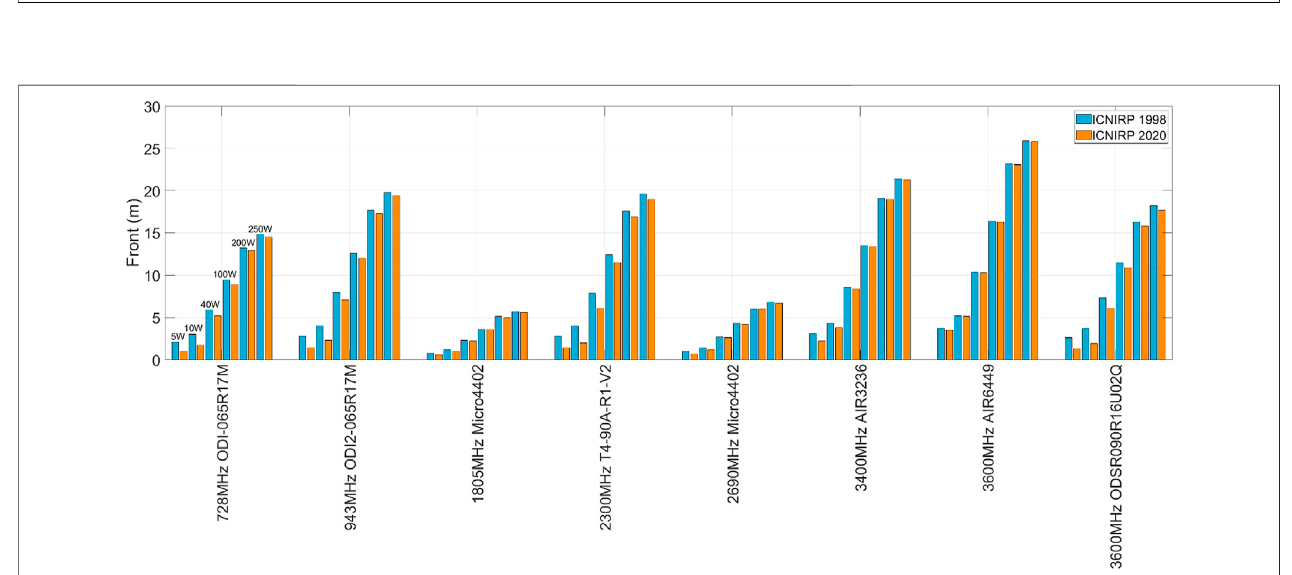
FIGURE 3 | Dimensions of the compliance boundary box in the front direction for the selected BS antennas (for frequencies below 6 GHz) obtained by applying ICNIRP 1998 and ICNIRP 2020 general public reference levels for input powers of 5, 10, 40, 100, 200, and 250 W.